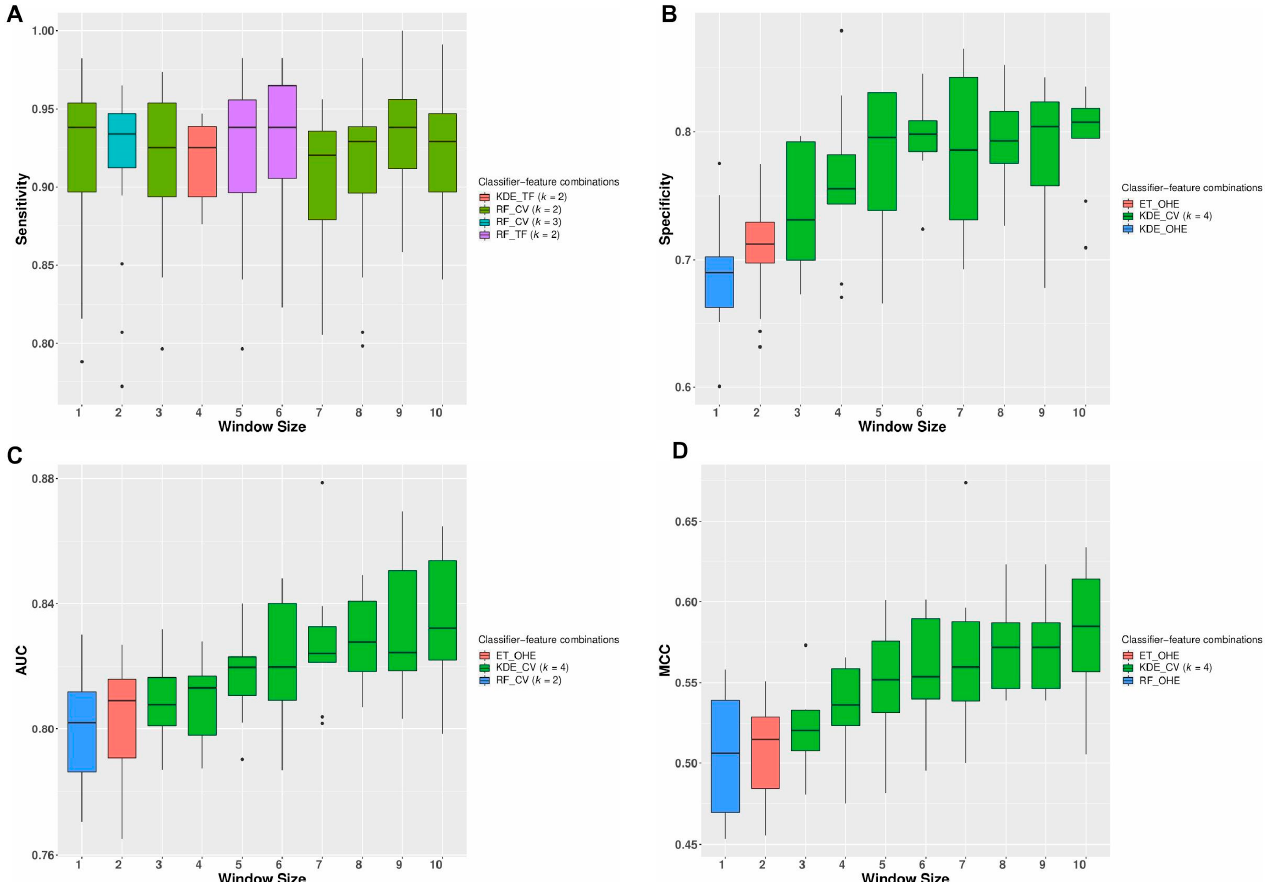
Figure 3. Repeated cross-validation results: The variation in the classification performances with different window sizes for the top feature-classifier combinations obtained during the repeated cross-validation experiments using the initial training set of 5265 mutations is shown in this figure. For each window size, the best results obtained using the different classifier-feature combinations in terms of ( A ) sensitivity, ( B ) specificity, ( C ) AUC, and ( D ) MCC are displayed.